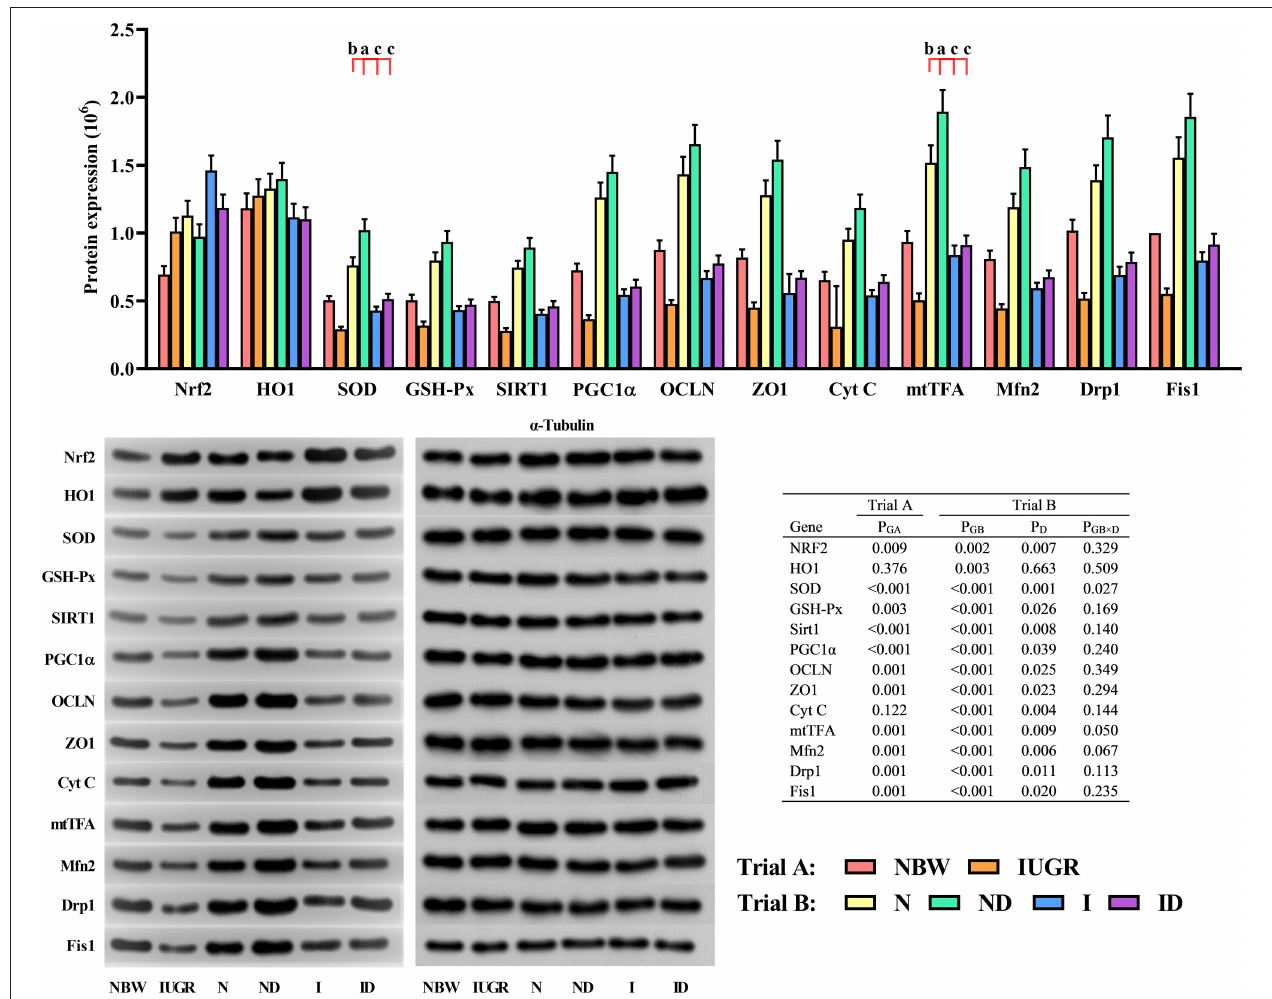
FIGURE 9 | Supplementation with DMG-Na improved the hepatic protein expression values in IUGR suckling piglets. Data are expressed as the mean ± SD, n = 10 suckling piglets per group. The P -value (Trial A: NBW, IUGR group in black color) and a, b, c, d (Trial B: N, ND, I, ID group in red color) represent significant differences ( P < 0.05). NBW, normal birth weight newborns; IUGR, intrauterine growth restriction newborns; N, NBW newborns fed a basic milk diet; ND, NBW newborns fed a basic milk diet plus 0.1% DMG-Na; I, IUGR newborns fed a basic milk diet; ID, IUGR newborns fed a basic milk diet plus 0.1% DMG-Na. Nrf2, nuclear factor